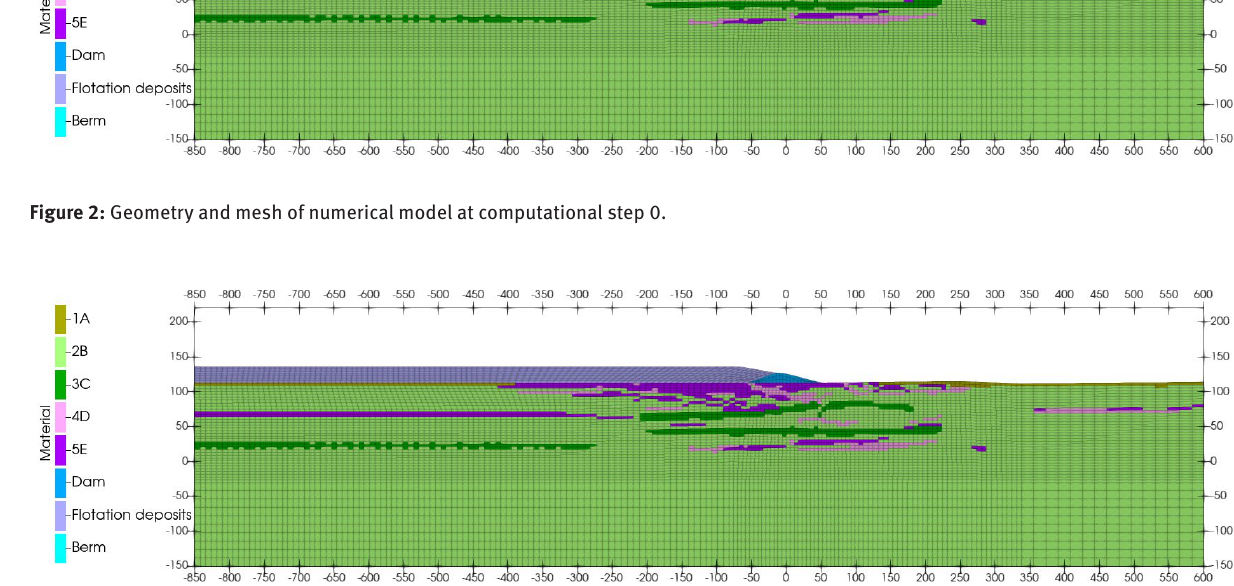
Figure 3 Geometry and mesh of numerical model at computational step 60